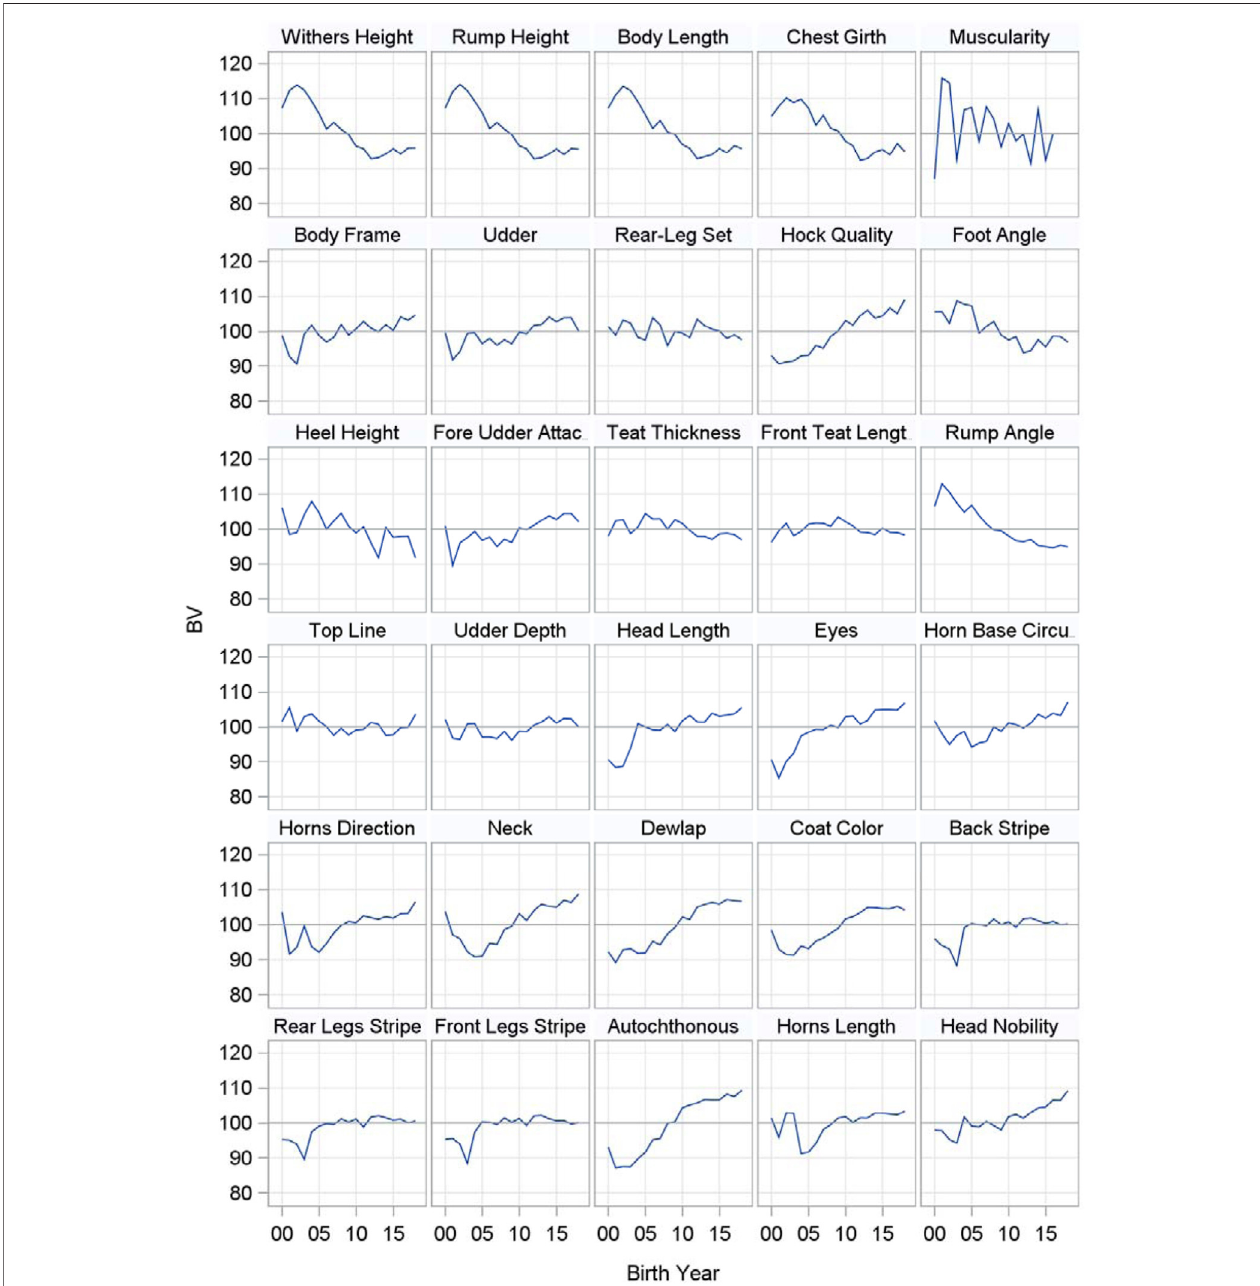
FIGURE 1 | Genetic trends for type traits in fi rst parity Cika cows born in the years 2000 – 2019.